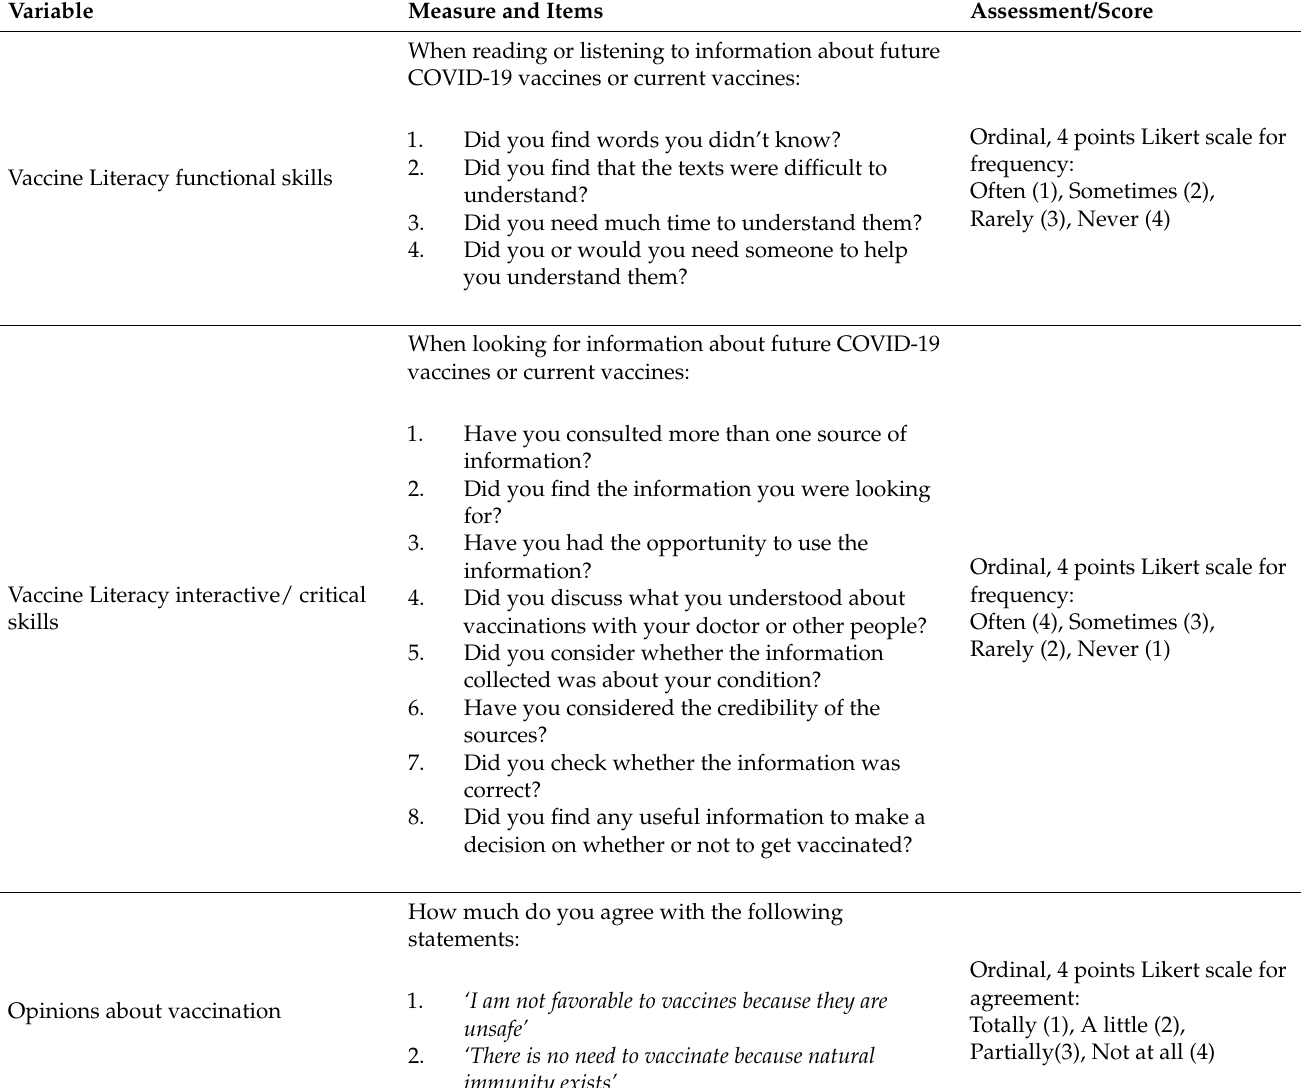
Table 1. June 2020 survey—questions used to assess skills, perceptions, attitudes, and opinions.